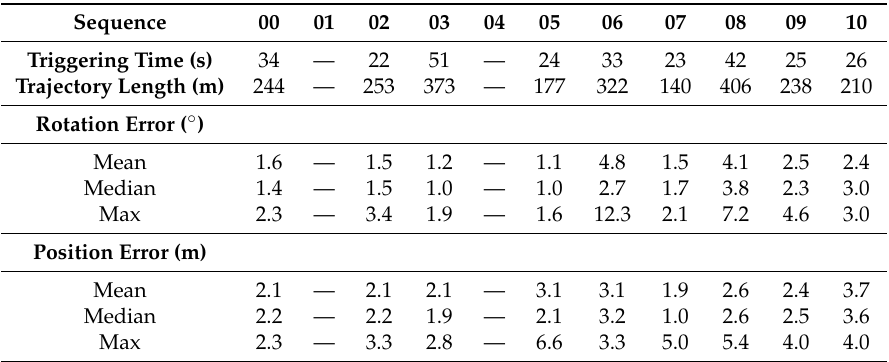
Table 2. Pose initialization of Global Navigation Satellite System–visual-ORB–simultaneous localization and mapping